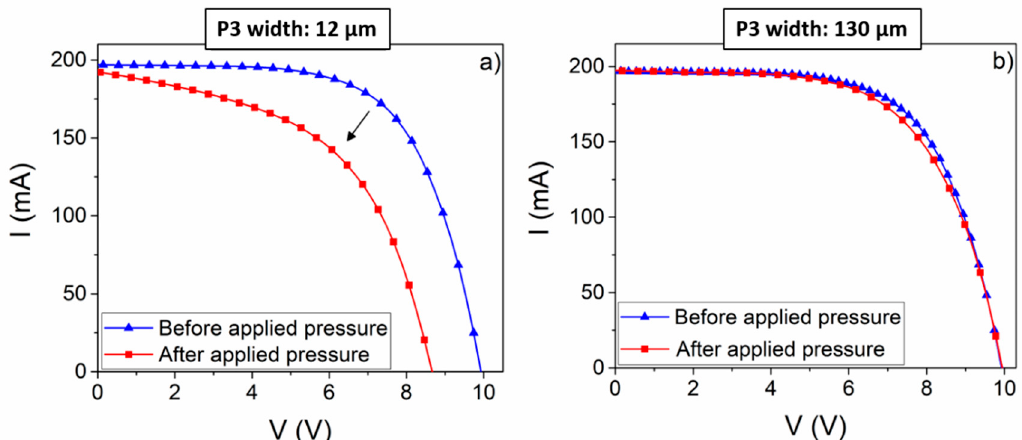
Figure 8. Module I-V curves, in panel ( a ) are reported for a module obtained with a non-optimized P3 process before and after the application of the lamination pressure showing a reduction in PCE from 15.3% to 10.45%; ( b ) the same but with a P3 ablated area of 130 μ m.